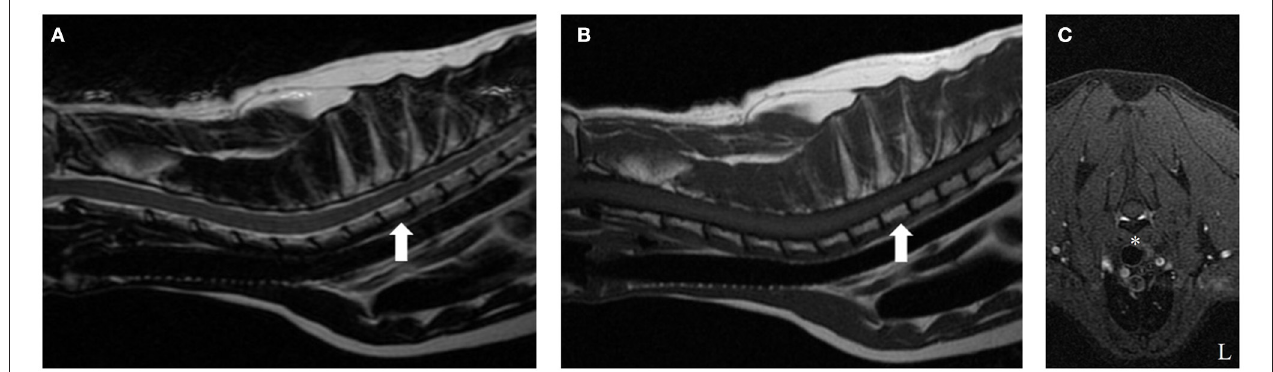
FIGURE 2 | T2-weighted (A) , T1-weighted (B) , and T1-weighted fat suppression post-contrast (C) cervicothoracic images of the same cat 2 years after starting melphalan. On the sagittal T2-weighted and T1-weighted images ( A,B , respectively), notice the isointense signal intensity of the T2 vertebral body (arrow) relative to all other vertebrae. The previously noted symmetric, ventrally located, extradural lesion causing secondary spinal cord compression at the level of mid-body of the T2 vertebra has resolved. There is no contrast enhancement on T1-weighted contrast fat saturation images (asterisk, E).